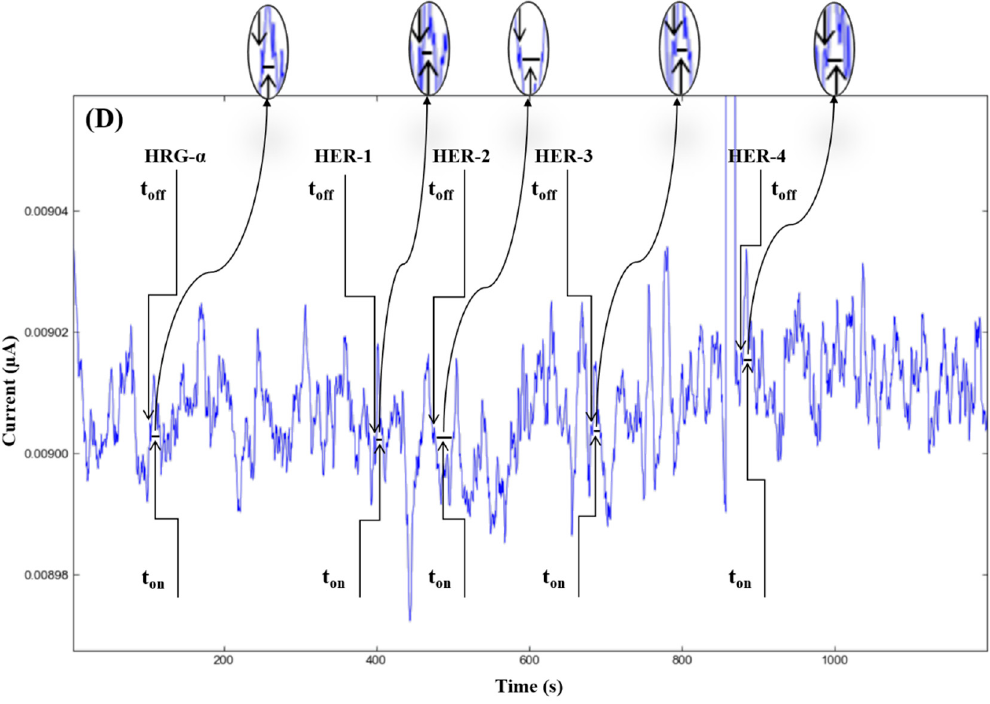
Figure 2. Stochastic diagrams recorded in brain tumor tissue samples with 3D stochastic microsen- sors based on IN/AuNP-MWCNT ( A ), IQ/AuNP-MWCNT ( B ), HD/AuNP-MWCNT ( C ), and TEX/AuNP-MWCNT ( D ).